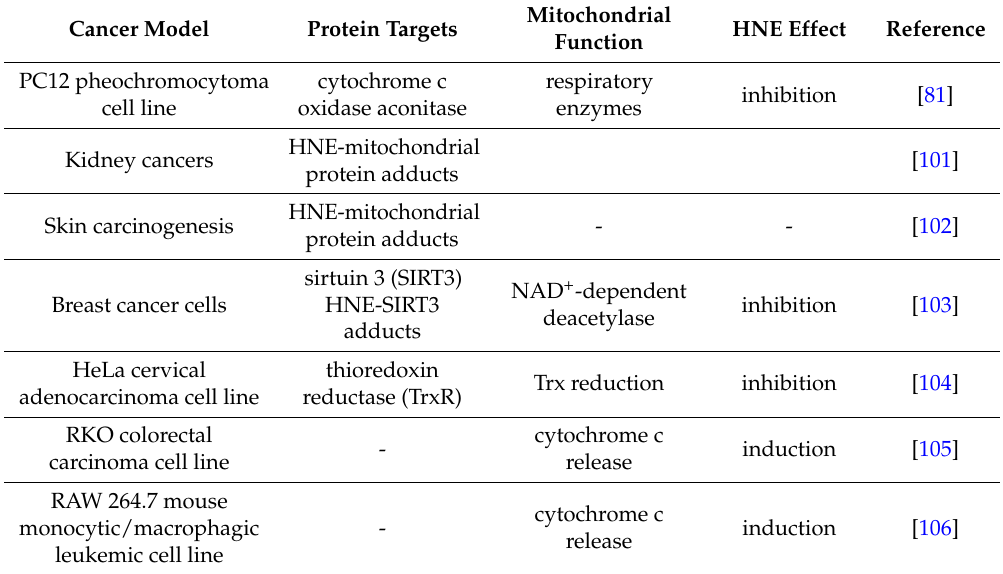
Table 3. HNE effects on mitochondrial proteins in cancer